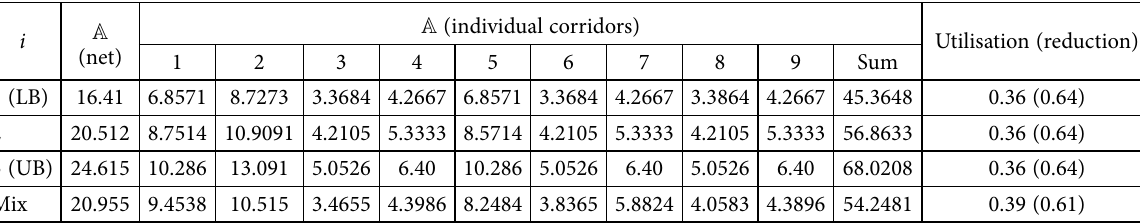
Table 2. Sensitivity analysis of absolute capacity per